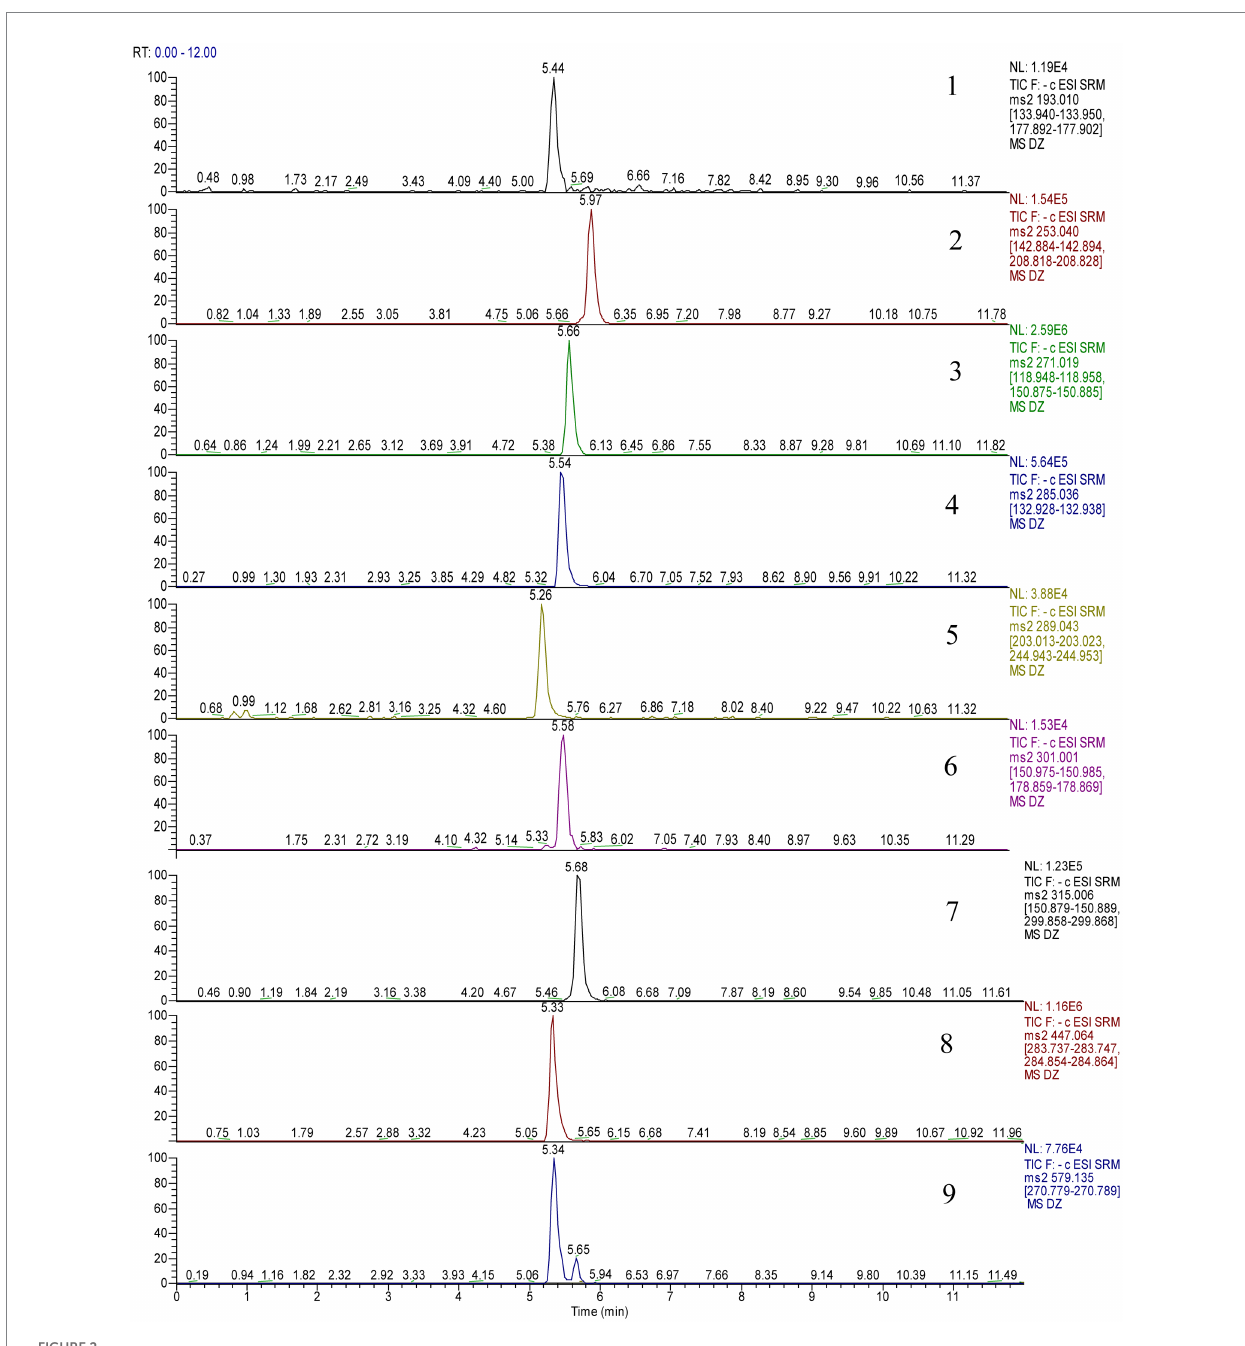
FIGURE 2 Multiple reaction monitoring (MRM) chromatograms of 9